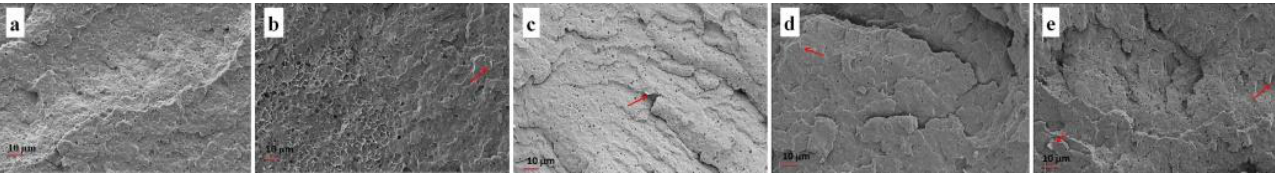
Figure 5. SEM images with magnification of 200 of ( a ) neat co-PP foam; ( b ) 1 wt % xGnP incorpo- rated by Method 1; ( c ) 2 wt % xGnP incorporated by Method 1; ( d ) 1 wt % xGnP incorporated by Method 2; ( e ) 2 wt % xGnP incorporated by Method 2, subjected to low SCF level (0.25 wt %) and ( f ) neat co-PP foam; ( g ) 1 wt % xGnP incorporated by Method 1; ( h ) 2 wt % xGnP incorporated by Method 1; ( i ) 1 wt % xGnP incorporated by Method 2; ( j ) 2 wt % xGnP incorporated by Method 2, subjected to a high SCF level (0.35 wt %). SEM: scanning electron microscopy; xGnP: graphene plate- let; co-PP: copolymer polypropylene; SCF: supercritical fluid. Figure 5a – j show the representative foam morphology of the neat polymer and its nanocomposite counterparts prepared by Methods 1 and 2, and being subjected to 0.25 wt % (low) and 0.35 wt % (high) (supercritical fluid) SCF percentages. To quantitatively eval- uate average cell size and density, the ratio of skin thickness to foam thickness was ex- tracted from SEM images by using Image J software and is shown in Table 6. Figure 5a,f shows neat polypropylene foams exhibiting copolymeric morphological characteristics of nonuniform cell distribution with polydisperse cell sizes governed by different SCF dis- solution affinities in polypropylene and ethylene phases [2]. Additionally, collapsed bubbles were determined as being due to poor melt strength. Likewise, cell sizes of a few hundred elongated microns were determined in neat samples as having been caused by insufficient SCF levels and dominant shear forces, as expected [43]. The incorporation of xGnP provides improved uniformity of cells compared to neat polypropylene copolymer due to its nucleating agent role. Additionally, cells formed in